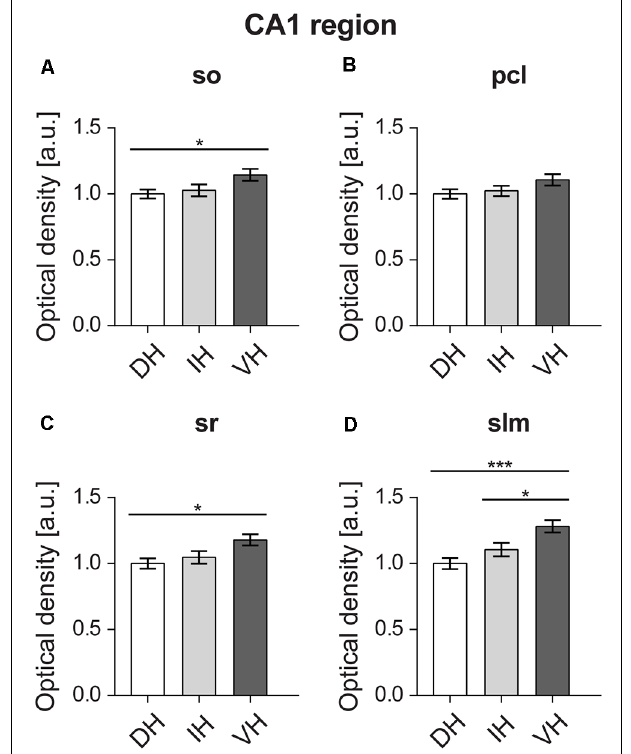
FIGURE 6 | D2R expression is higher in the ventral CA1 region. Proximal dendrites (A,C) of the ventral relative to the dorsal CA1 display high D2R protein levels. D2R show similar expression levels throughout the pyramidal cell layer (pcl) layer of the CA1 region (B) . Distal dendrites of the ventral CA1 express higher D2R levels compared to the dorso-intermediate parts. (D) A gradient of expression of D2R occurs in the Stratum lacunosum moleculare. Expression is highest in the ventral, and lowest in the dorsal SLM. Values expressed in arbitrary units (a.u.). Error bars indicate SEM. ∗ p < 0.05 or ∗∗∗ p < 0.001. so, Stratum oriens; pcl, pyramidal cell layer; sr, Stratum radiatum; and slm, Stratum